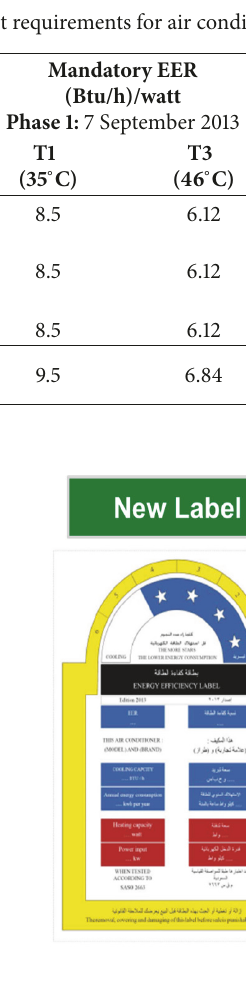
Figure 2: New label of new star energy efficiency standard